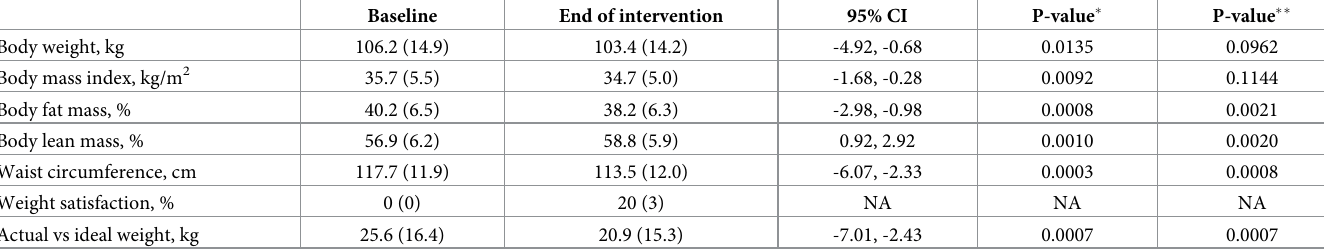
Table 2. Change in adiposity from baseline to end-of-intervention. The RESTART pilot study 2017–18.